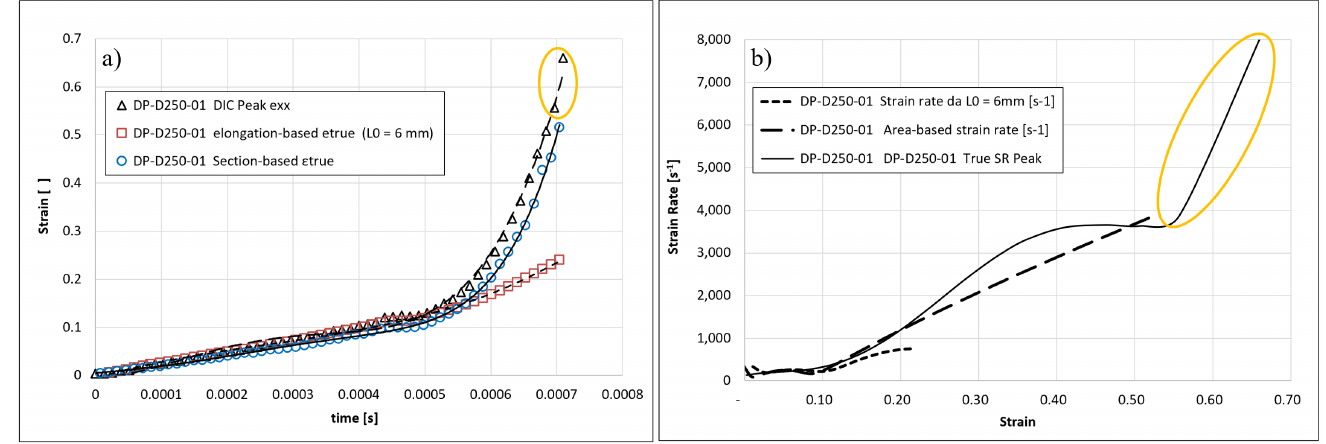
Figure 11. Dynamic SHTB DP-D250-01 test: Strain vs. time trends ( a ) and resulting strain rate histories ( b ).